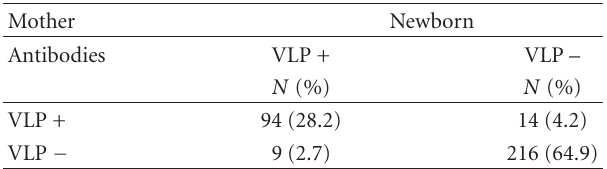
Table 3: Concordance between mother and newborn for anti-HPV VLP 16, 18, 31, or 33 ( N = 333).